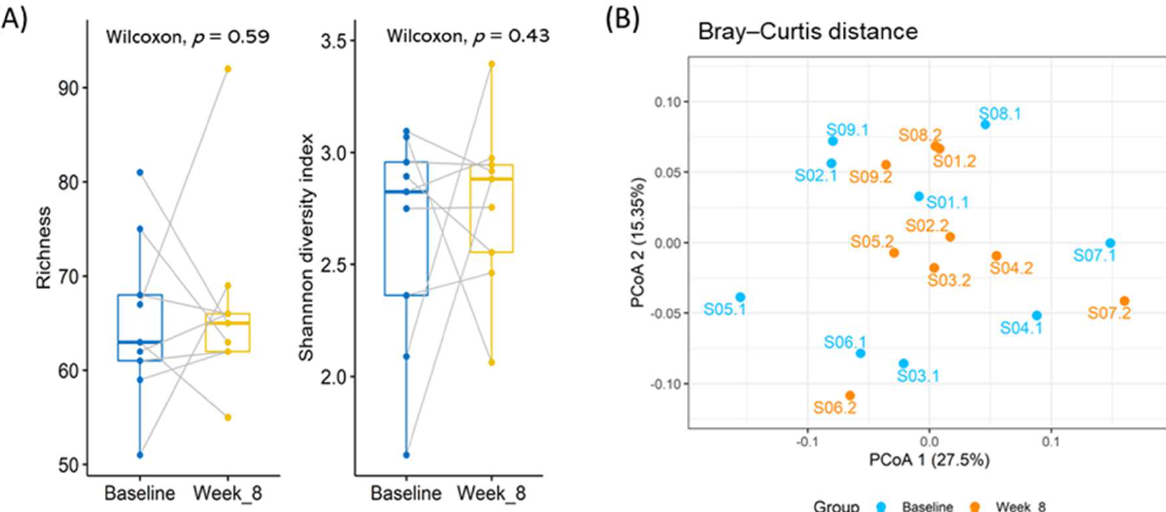
Figure 2. Microbial diversity at genus level. ( A ) Alpha diversity was assessed using richness and the Shannon diversity index. The richness of microbial diversity means the number of genera detected within each fecal sample. Both richness and the Shannon diversity index did not show significant differences between the two sample collection times. ( B ) Principal coordinate analysis (PCoA) was based on the Bray–Curtis distance. Each point represents one fecal sample. The two colors represent the two collection times, with blue denoting baseline and orange denoting eight weeks after consumption of